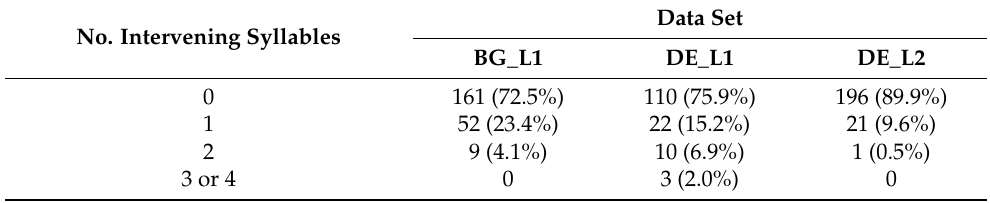
Table 4. Number of intervening syllables between L* and H (in % in parenthesis) in the three data sets. No. Intervening